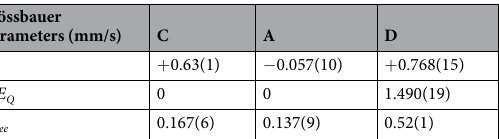
Table 1. Mössbauer parameters at RT for the C, A, and D components, as determined by fitting the eMS data of GeTe-2, being: δ the isomer shift, ΔΕ Q the quadrupole splitting, and σ free is the additional Gaussian broadening free to vary in the fitting